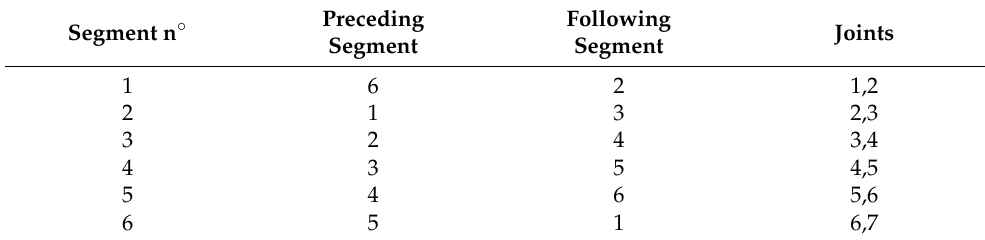
Table 1. Partitioned airfoil topology.